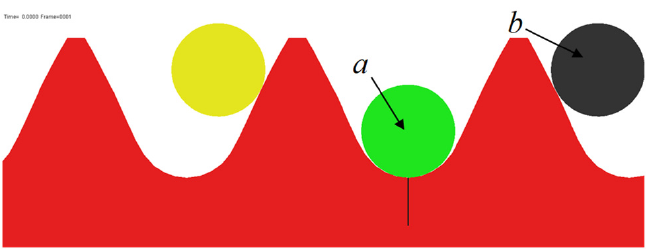
Figure 9. Simulation result of point 1. Figure 10 corresponds to the simulation result of point 2 in Figure 8. The number of